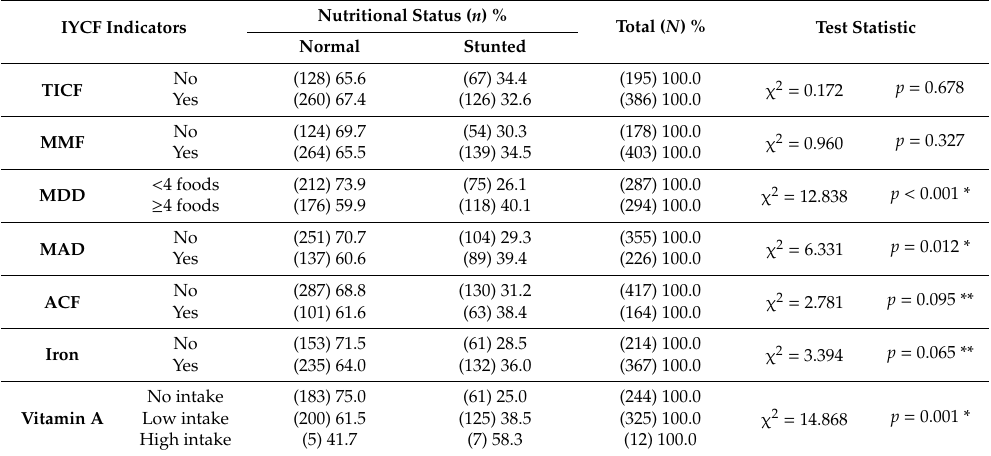
Table 5. Bivariate analysis of the association between IYCF indicators and stunting ( n = 581).